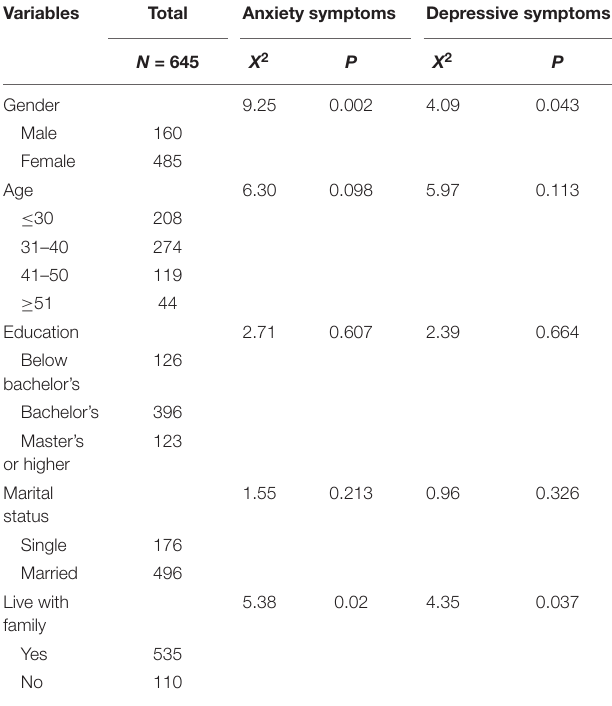
TABLE 1 | Demographic characteristics of the study participants ( N =